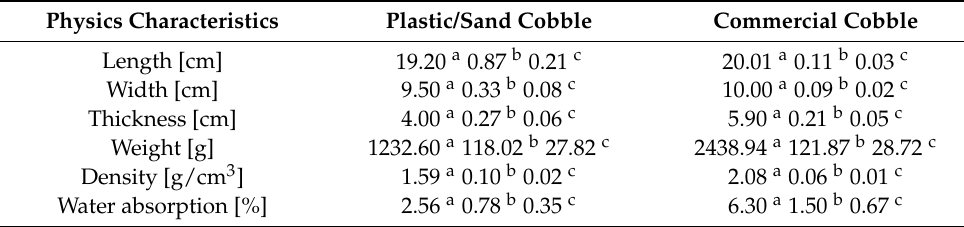
Table 1. Physical characteristics of plastic sand and commercial